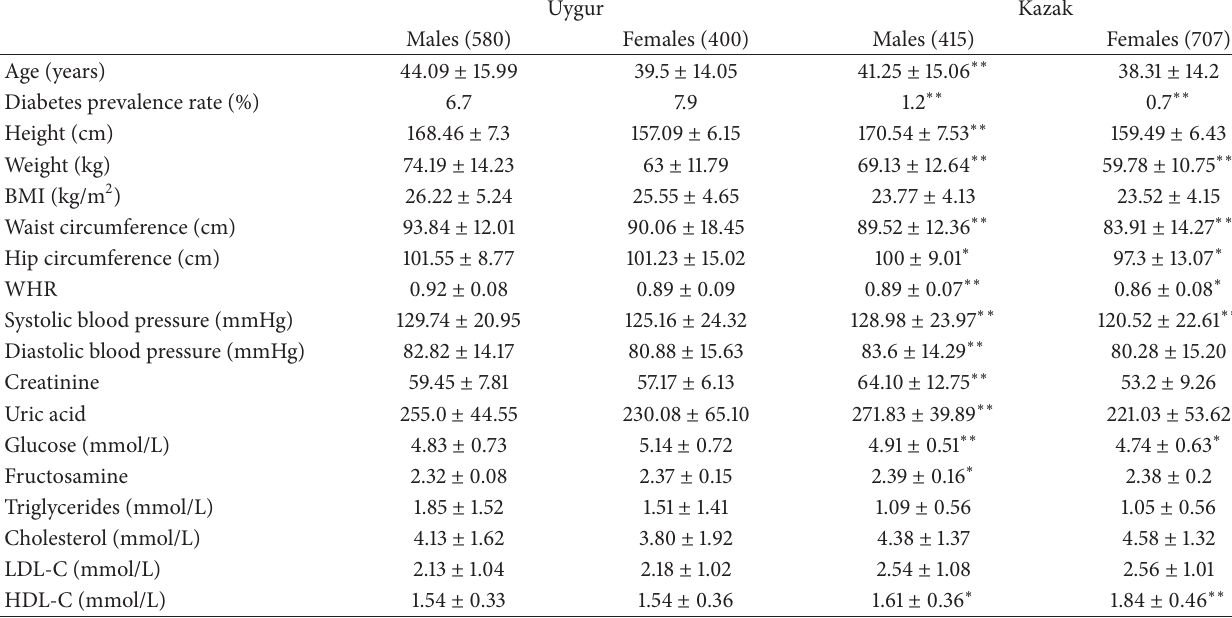
Table 2: Basic indices and biochemical analyses.